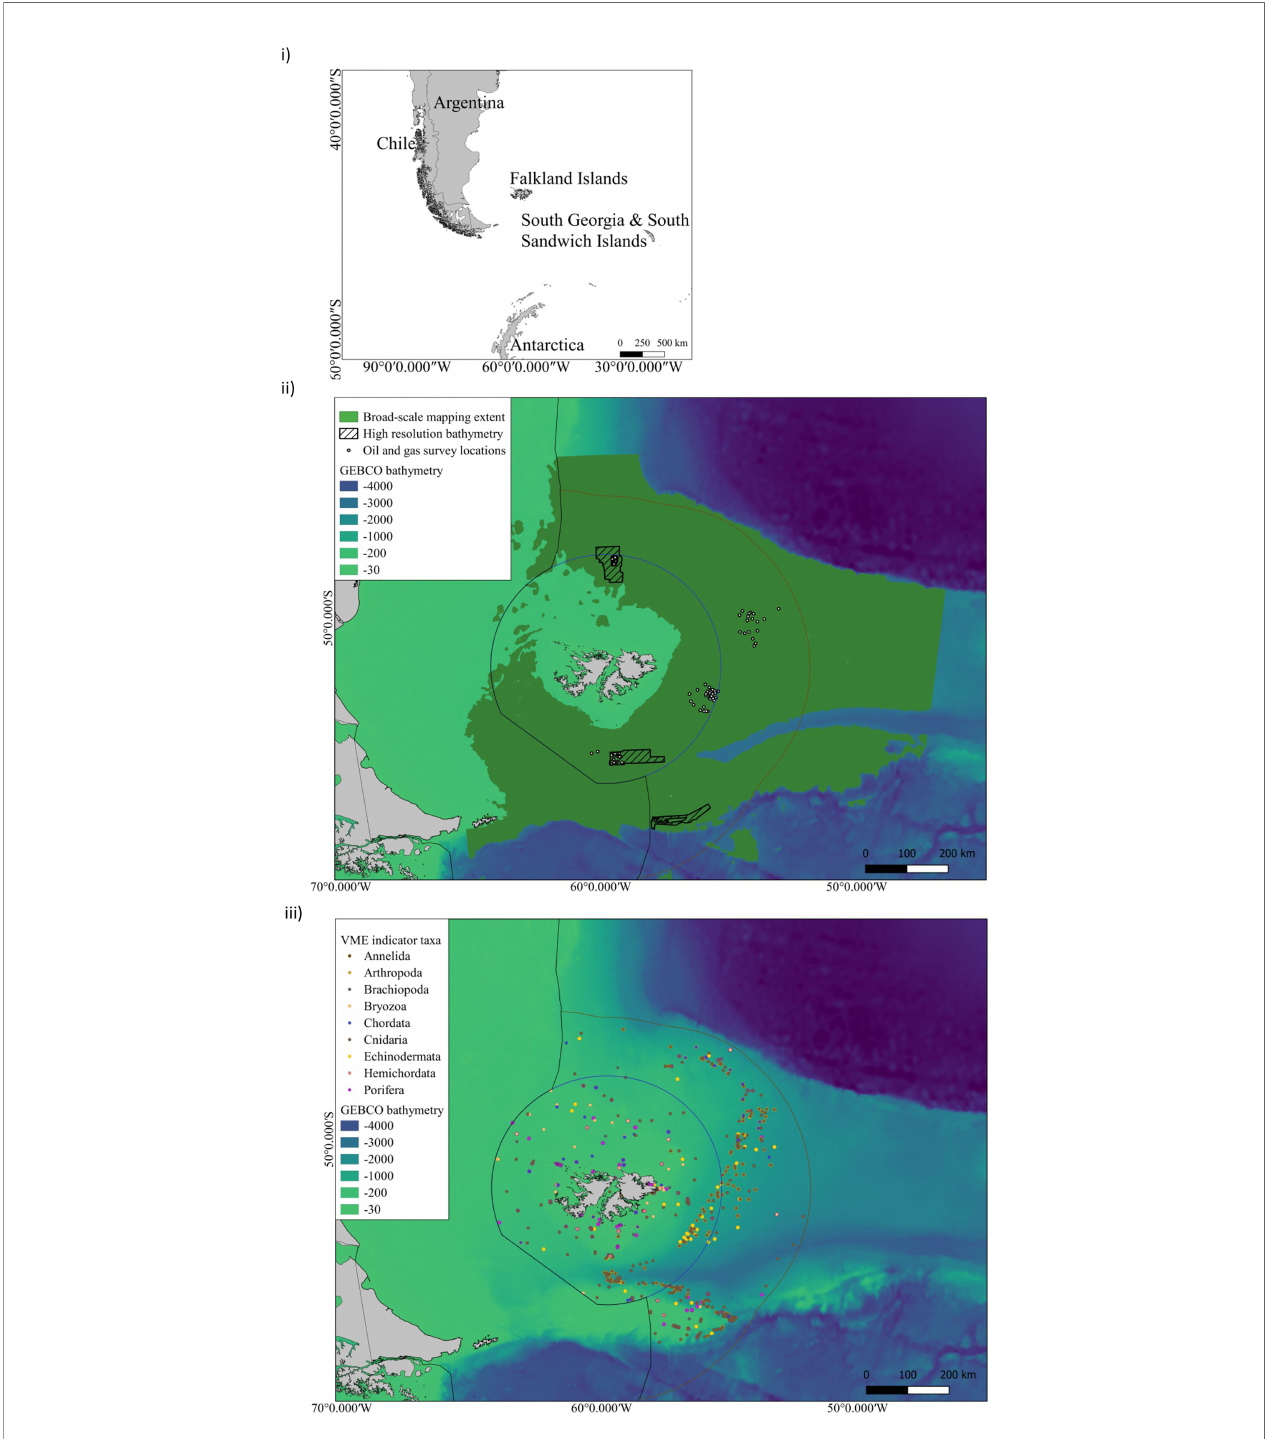
FIGURE 2 | i) The Falkland Islands geographic location in the South West Atlantic ii) Distribution of offshore surveys in FCZs: Broad-scale classi fi cation habitat maps and predictive maps of VME taxa as proxies of VMEs have been produced over the spatial extent indicated in dark green. These broad-scale maps have been based upon GEBCO bathymetry. Higher resolution mapping has been undertaken at oil and gas survey point locations shown by white circles (2x2km 2 ). High-resolution bathymetry has been collected at these sites and within the hashed boxes. ii) VME indicator taxa compiled from OBIS, SAERI unpublished data and Brewin et al., 2020 ( SI.1 Table 2 ) for the following taxa grouped by Phylum - Annelida - Serpulidae; Arthropoda - Bathylasmatidae; Brachiopoda; Bryozoa; Chordata- Ascidiacea; Cnidaria- Actiniaria, Alcyonacea, Pennatulacea, Scleractinia, Antipathraia, Hydroidolina, Stylasteridae; Echinodermata- Crinoidea, Ophiurida, Cidaroida; Hemichordata;